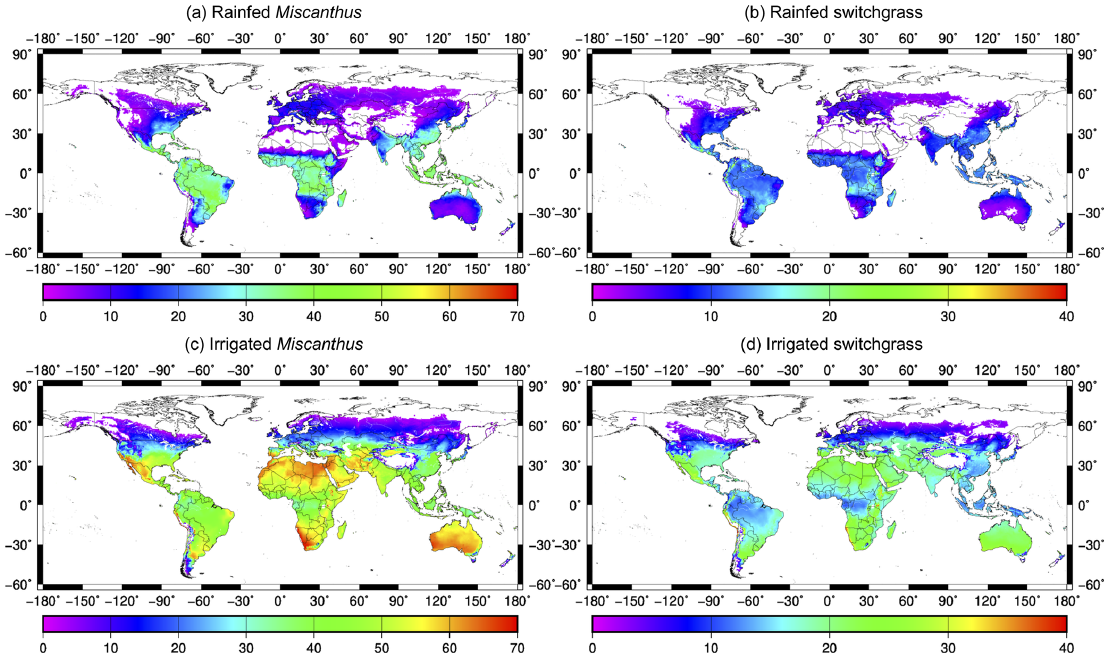
Figure 9. Spatial distributions of the simulated yields (exceeds 2Mgha − 1 yr − 1 ) for Miscanthus (a, c) and switchgrass (b, d) under rainfed (a, b) and irrigated (c, d) conditions. The units for the legends are Mgha − 1 yr − 1